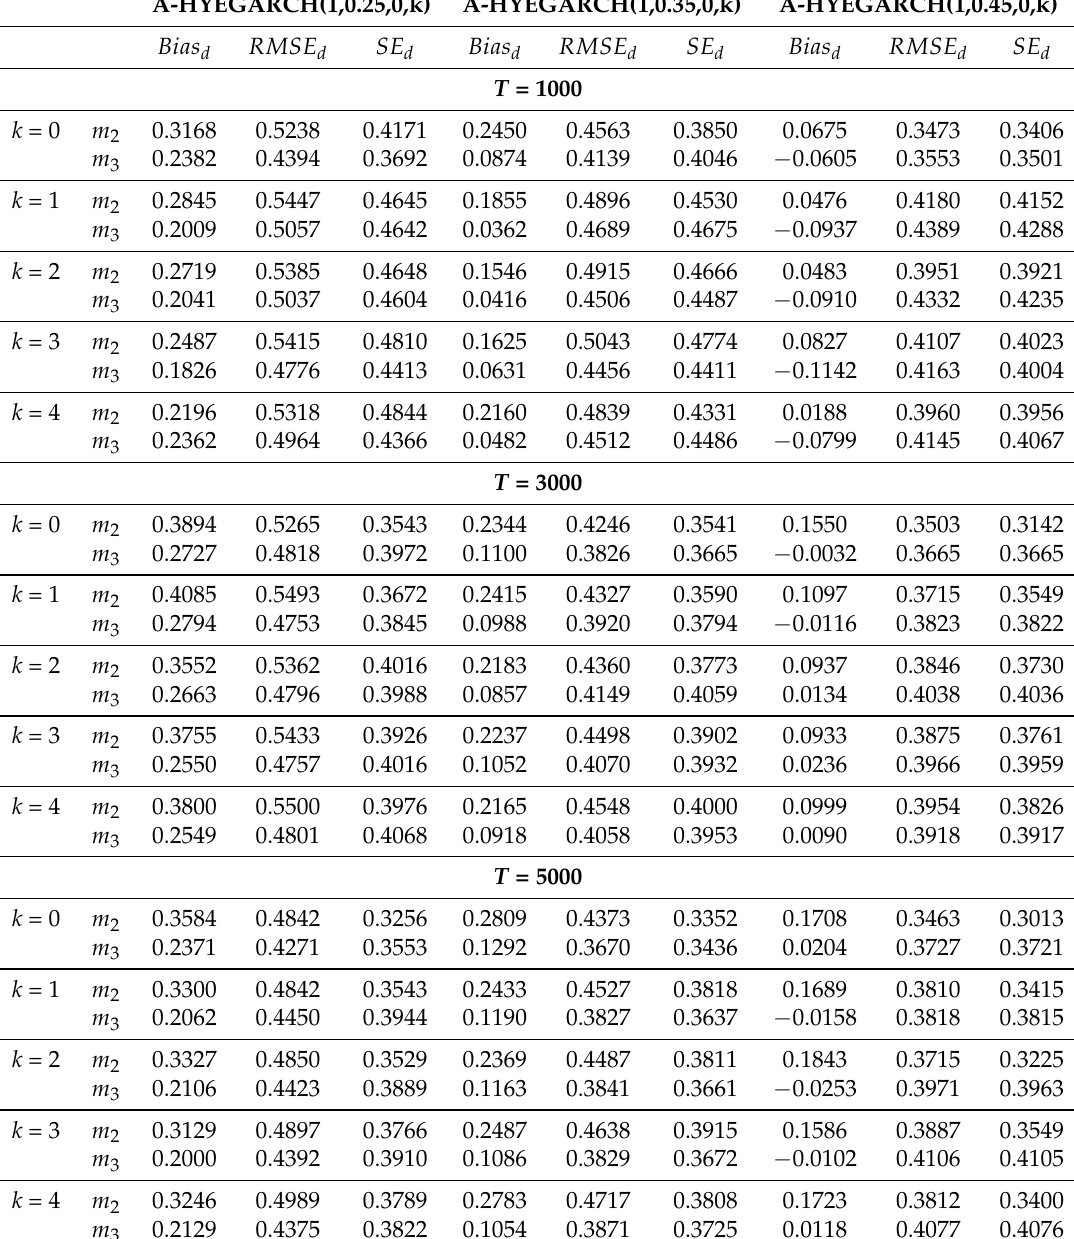
Table 4. Simulation results for estimation of A-HYEGARCH ( 1, d ,0, k ) models with various structural change